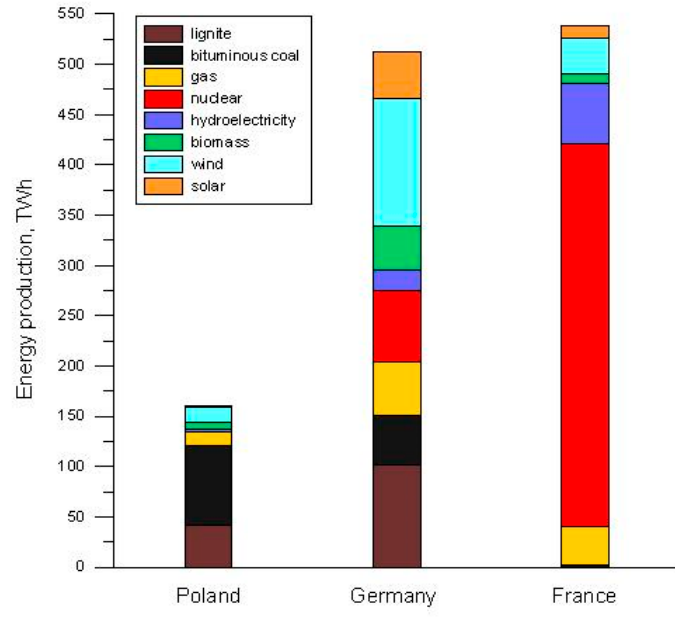
Figure 1. Energy production from di ff erent energy sources in selected European countries in 2019 [1– 3].